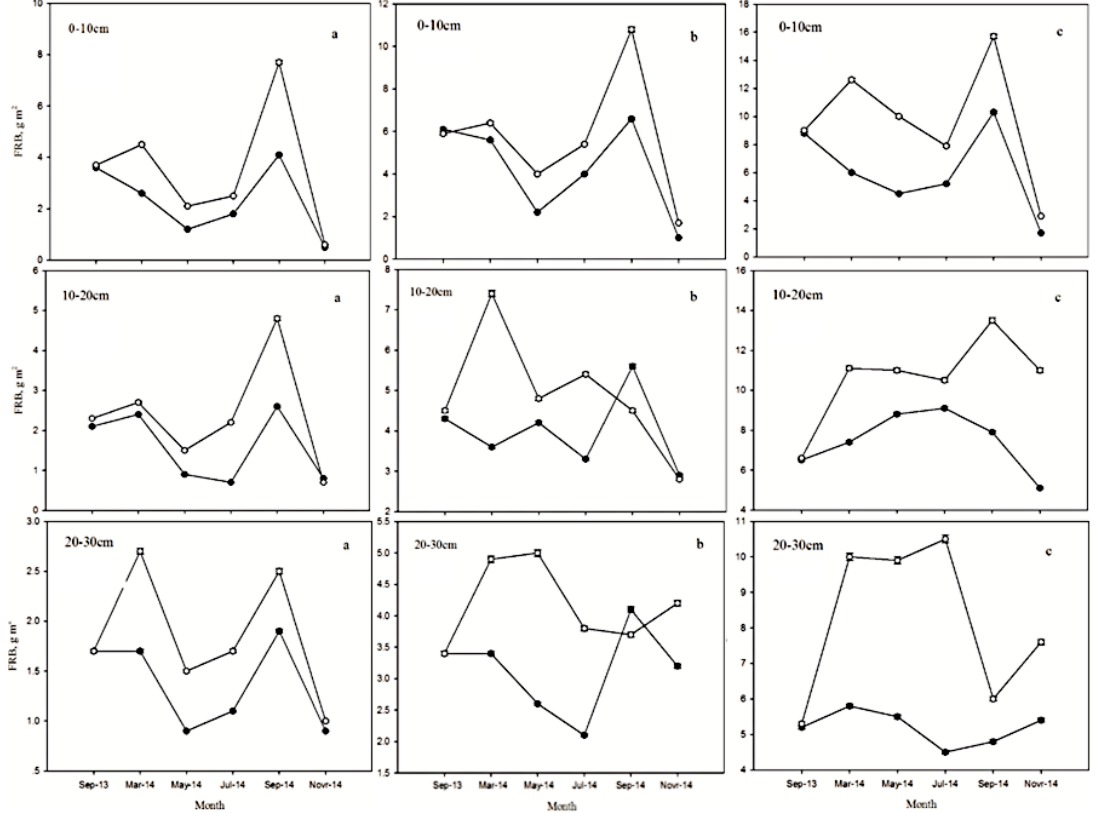
Figure 4. Seasonal variation of P. massoniana fine root biomass (FRB) (g m − 2 ) of roots with diameter ≤ 0.5 ( a , d , g ), 0.5–1 ( b , e , h ), and 1–2 mm ( c , f , i ) at depth intervals of 0–10, 10–20, and 20–30 cm in the control and thinned plots. Closed and open circles represent the FRB in the control and thinned plots, respectively. Error bars denote standard errors.